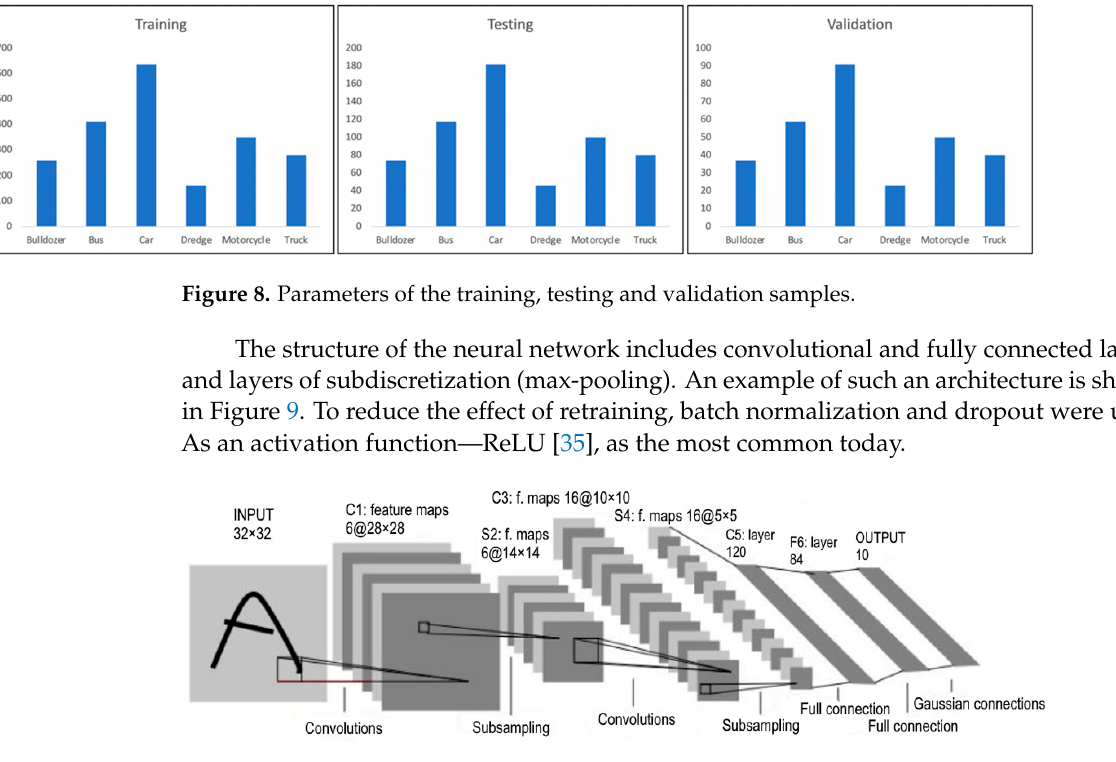
Figure 7. Data Collection Installation.